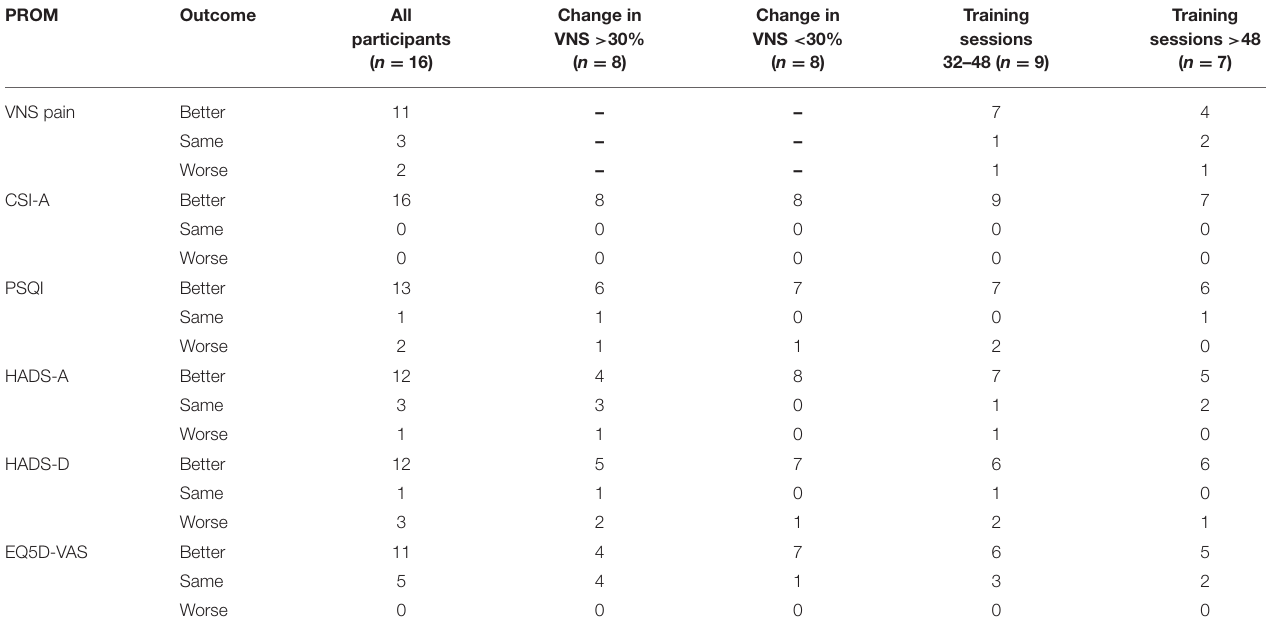
TABLE 4 | Categorical results for the primary and secondary outcome measures at the 12-week follow-up assessment stratified by degree of improvement in pain and number of NFB training sessions. PROM